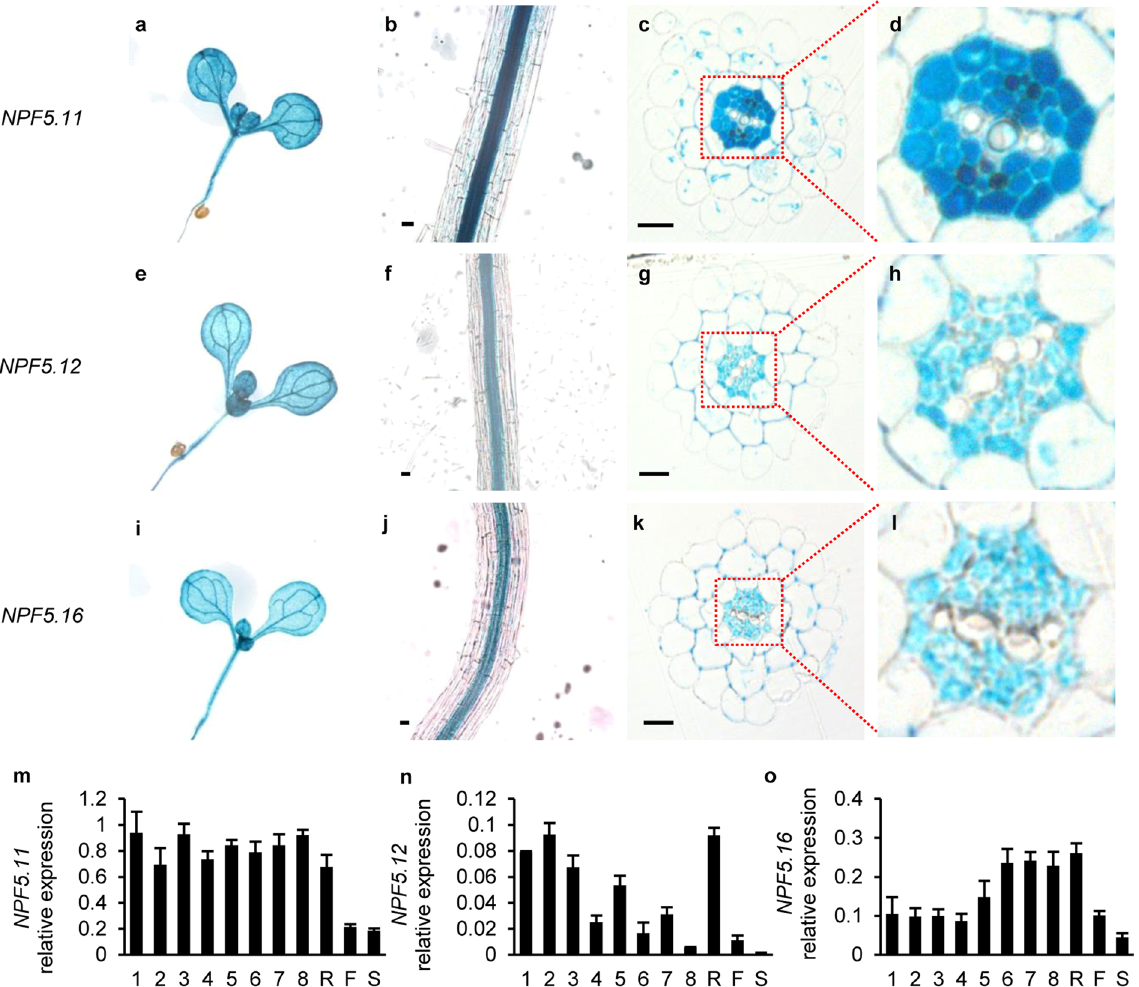
Figure 3. NPF5.11 , NPF5.12 and NPF5.16 are preferentially expressed in vascular tissues. Histochemical localization of GUS activity in NPF5.11 pro ::GUS transgenic plants ( a – d ), NPF5.12 pro ::GUS transgenic plants ( e – h ) and NPF5.16 pro ::GUS transgenic plants ( i – l ). The expression patterns of NPF5.11 , NPF5.12 and NPF5.16 were determined in whole-mount seedlings ( a , e , i ), seedling roots ( b , f , j ) or cross-sectioned seedling roots (c,d,g,h,k,l ). ( m , n , o ) Transcript expression of NPF5.11 ( m ), NPF5.12 ( n ) and NPF5.16 ( o ) in 28 d old plants. 1–8 indicated leaf positions arranged according to leaf ages (old to young); R, root; F, flower; S, stem. Data were normalized to that of SAND . Values are means ± SD, n = 3. Bars = 10 μ